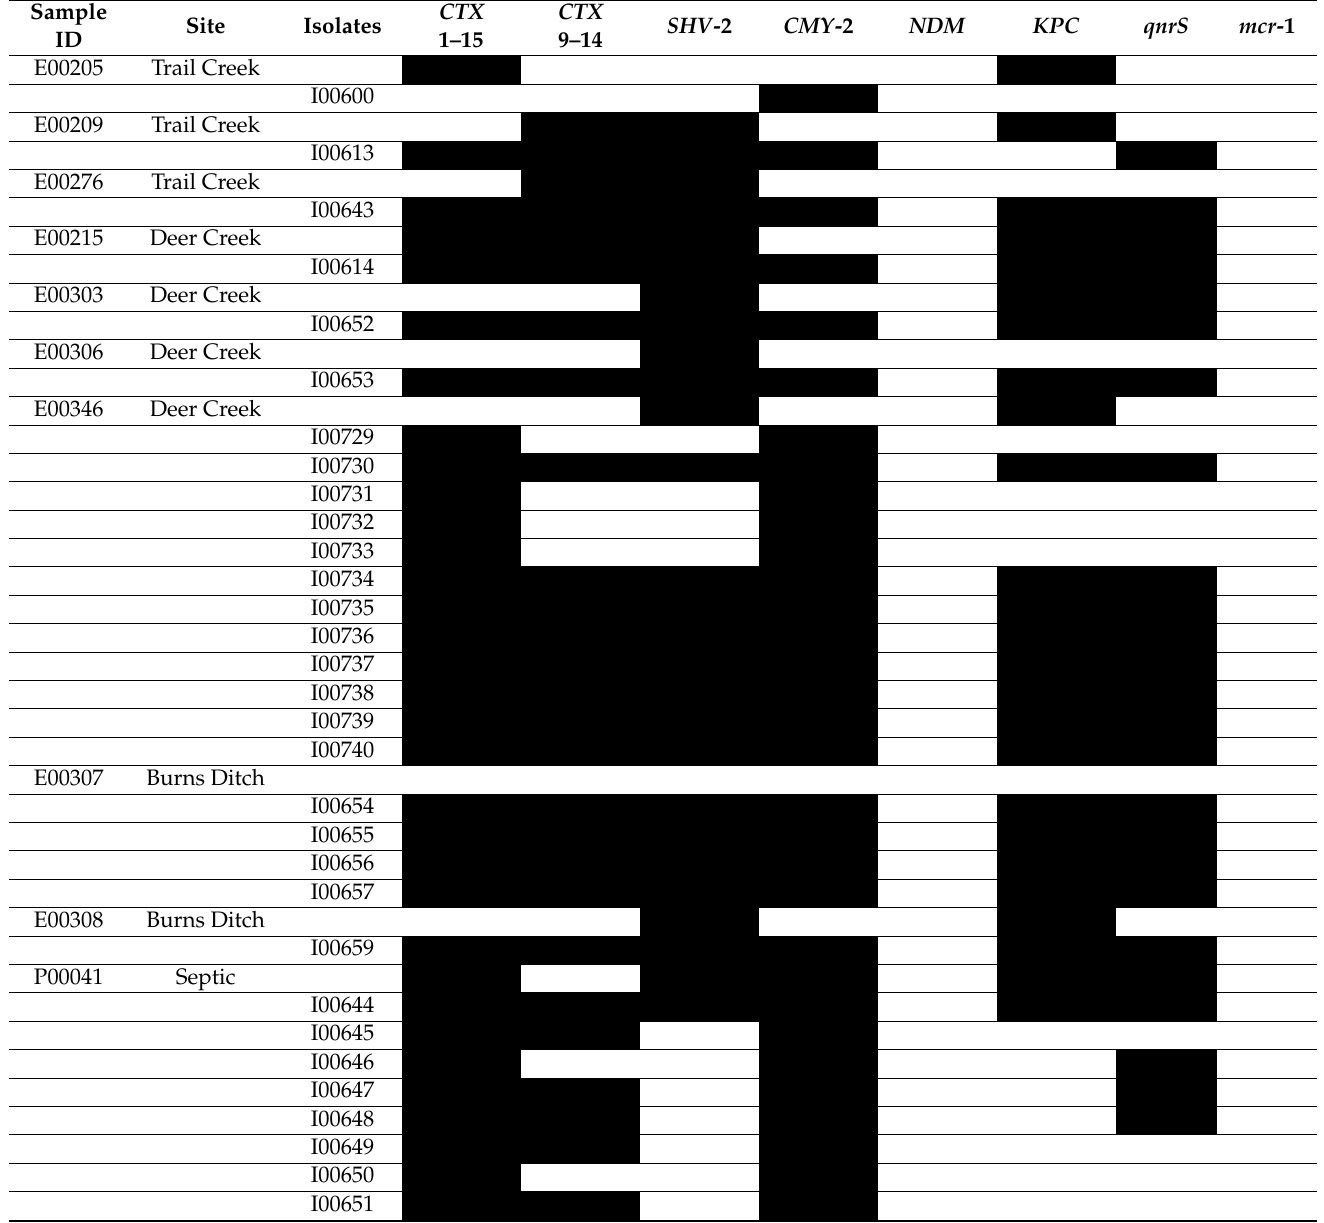
Table 3. Comparison of AMR genes amplified in E. coli isolates and their samples of